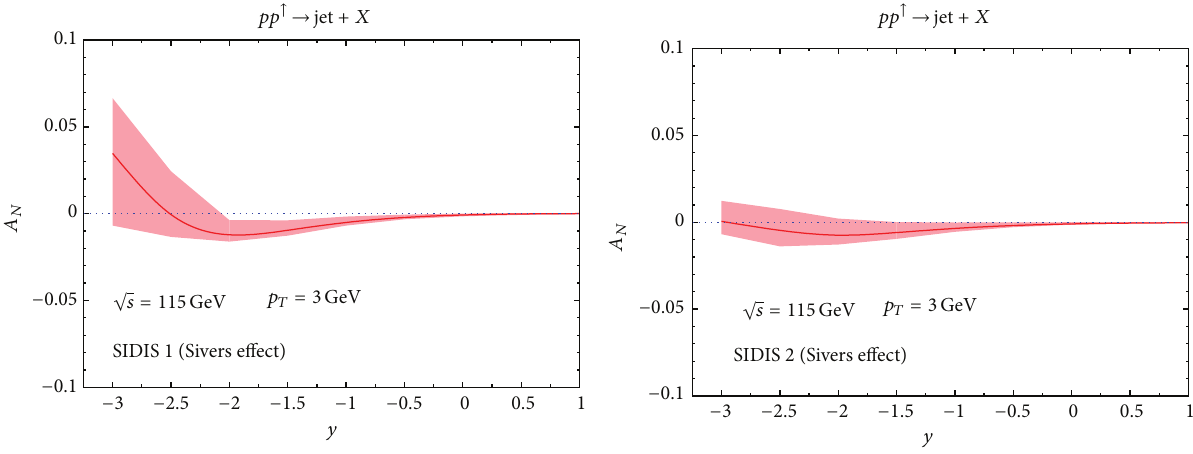
Figure 9: Our theoretical estimates for 𝐴 𝑁 versus 𝑦 at √𝑠 = 115 GeV and 𝑝 𝑇 = 3 GeV, for inclusive single jet production in 𝑝𝑝 ↑ → jet 𝑋 processes, computed according to (6)–(8) of the text. Only the Sivers effect contributes. The computation is performed adopting the Sivers functions of [20] (SIDIS 1, left panel) and of [21] (SIDIS 2, right panel). The overall statistical uncertainty band, also shown, is the envelope of the two independent statistical uncertainty bands obtained following the procedure described in Appendix A of